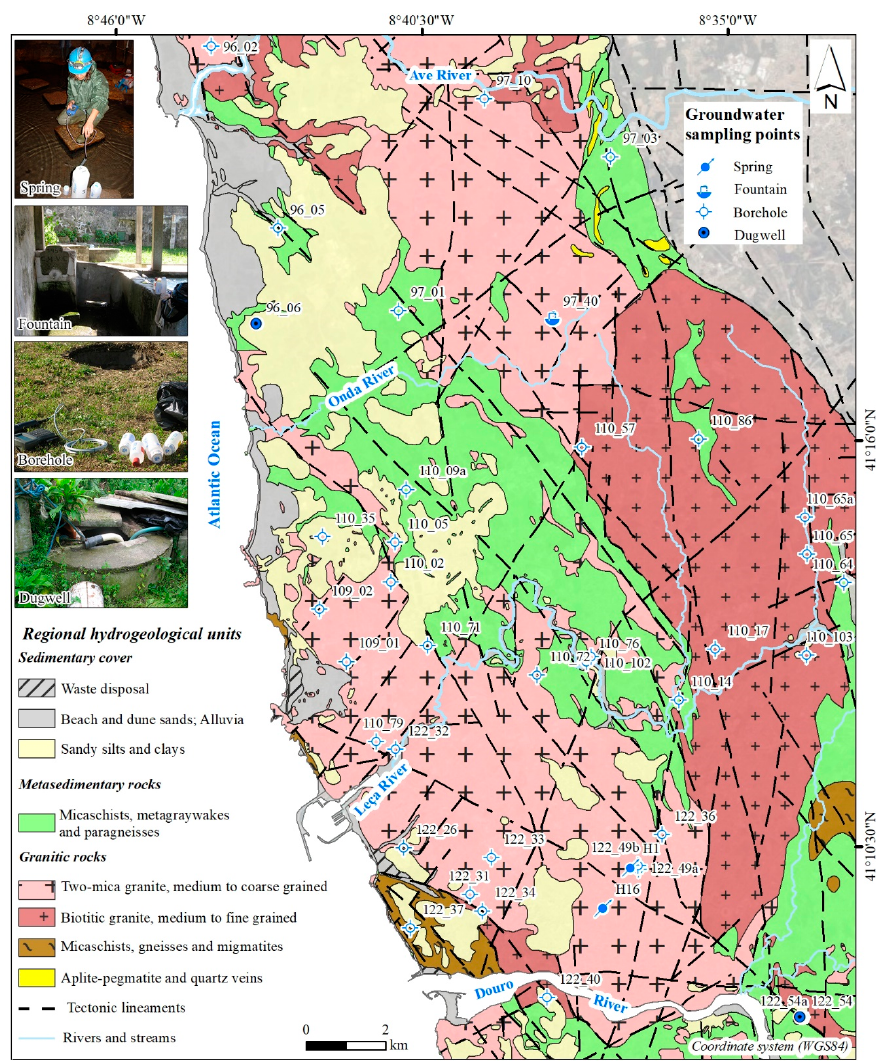
Figure 2. Regional hydrogeological setting of the Porto urban region (NW Portugal). Geological background updated from [63,65,69,70]. Hydrogeological framework adapted from [61,71,72]. Hydrogeological inventory and groundwater sampling points from [61]. Among the 40 samples, isotopic determinations of δ 18 O, δ 2 H, and 3 H were performed in 14 boreholes, 2 dugwells, and 2 springs in one fieldwork campaign. All the inventory and sampling sites were georeferenced with a high-accuracy GPS (Trimble ® GeoExplorer, Sunnyvale, CA, USA). In situ measurements included water temperature (°C), pH, electrical conductivity (µ Scm − 1 ), dissolved oxygen (mg L − 1 ), and redox potential (mV) using a multiparametric portable equipment (Hanna Instruments, HI9828). The hydrogeochemical analyses included major and minor element